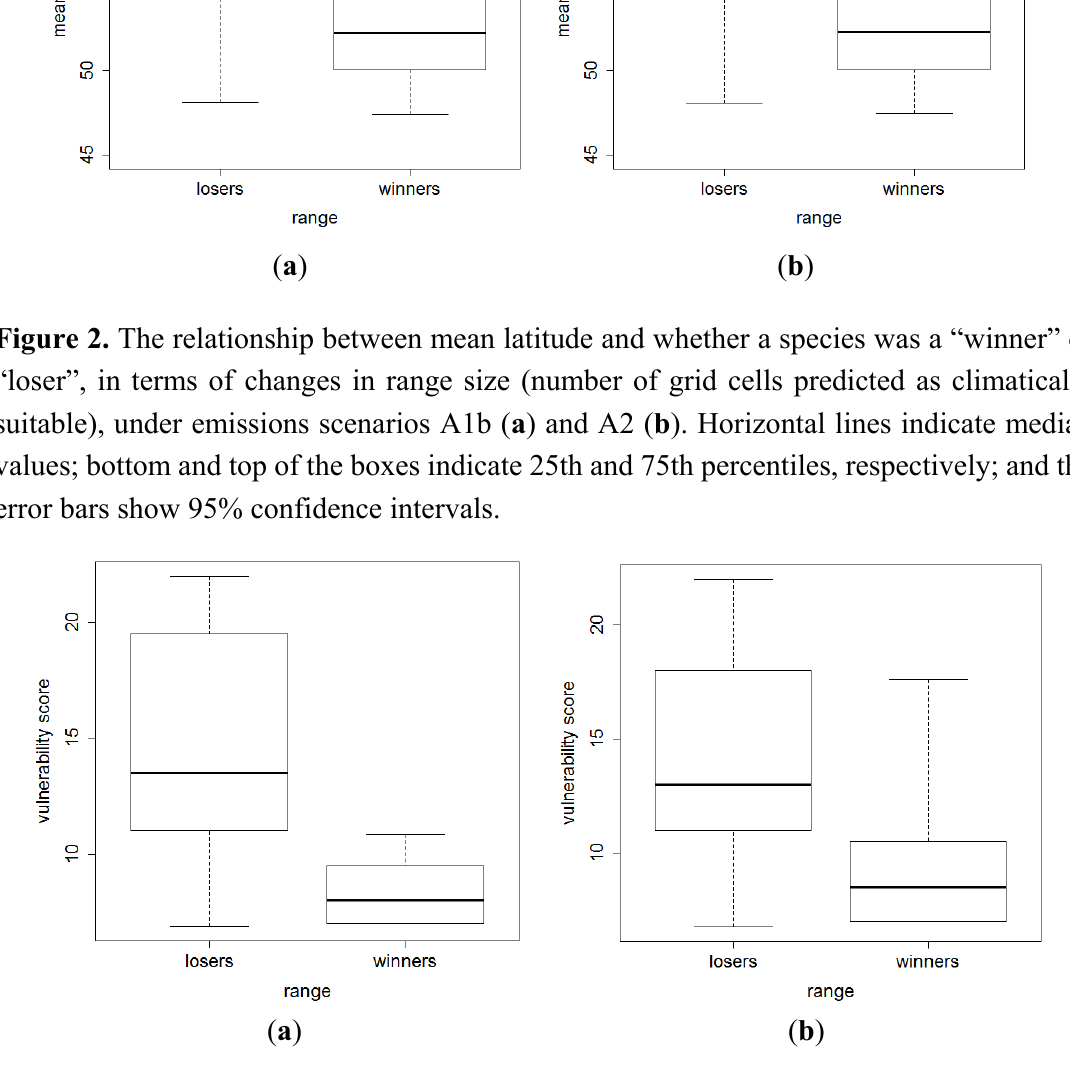
Figure 3. The relationship between vulnerability score to low prey availability [39] and whether a species was a “winner” or “loser”, in terms of changes in range size (number of grid cells predicted as climatically suitable), under emissions scenarios A1b ( a ) and A2 ( b ). Horizontal lines indicate median values; the bottom and top of the boxes indicate 25th and 75th percentiles, respectively; and the error bars show 95% confidence